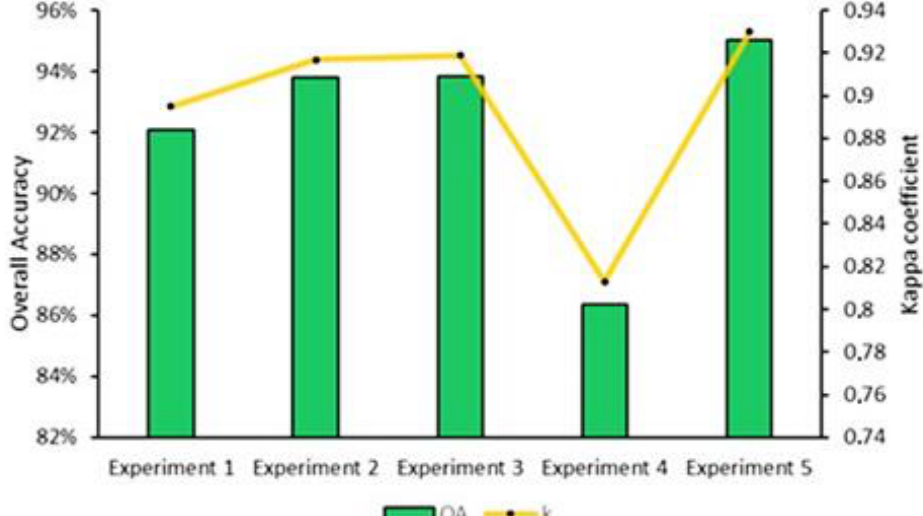
Figure 9. Classification accuracy of experiments using time series images.